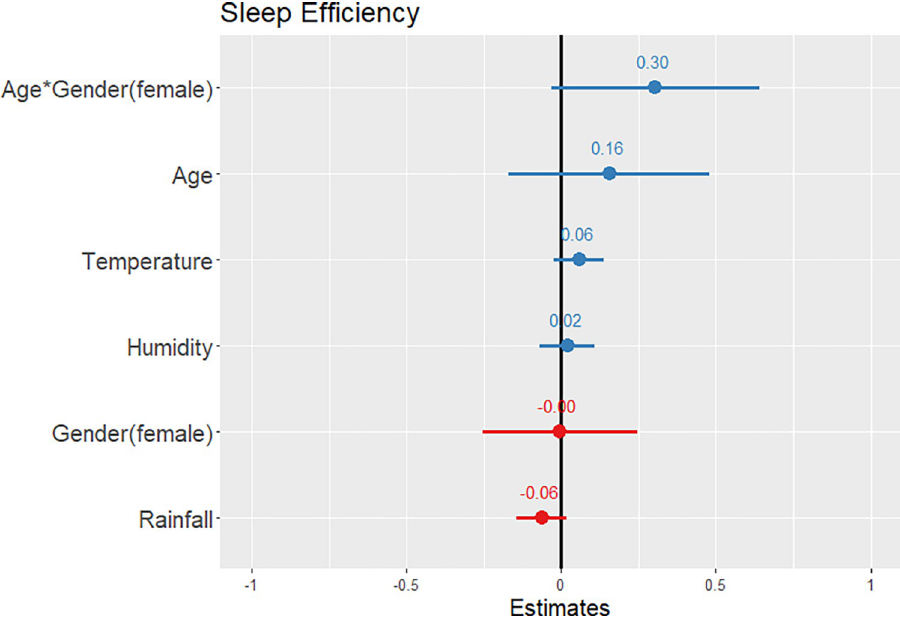
Fig 3. A prediction plot of standardized fixed effects for sleep efficiency. None of the included variables were significantly associated with sleep efficiency. Significance codes: � p < 0.05; �� p < 0.01; ��� p <